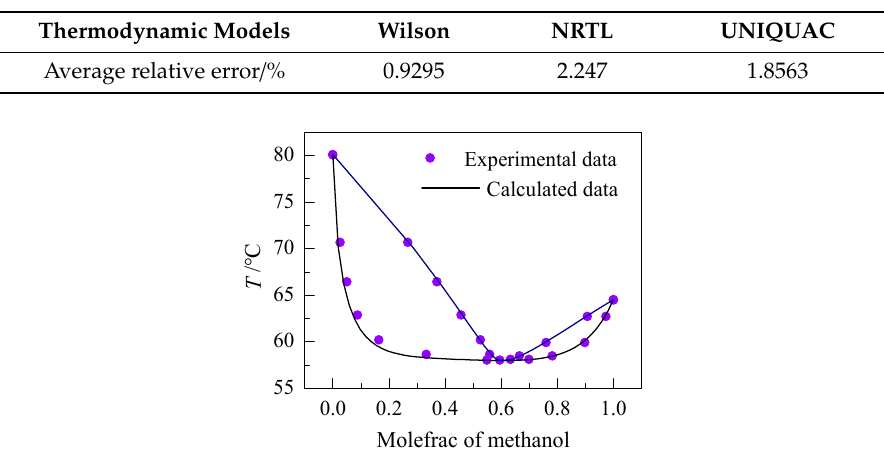
Figure 1. T-x-y diagram of benzene / methanol system with experimental data and calculated data at 1 bar.